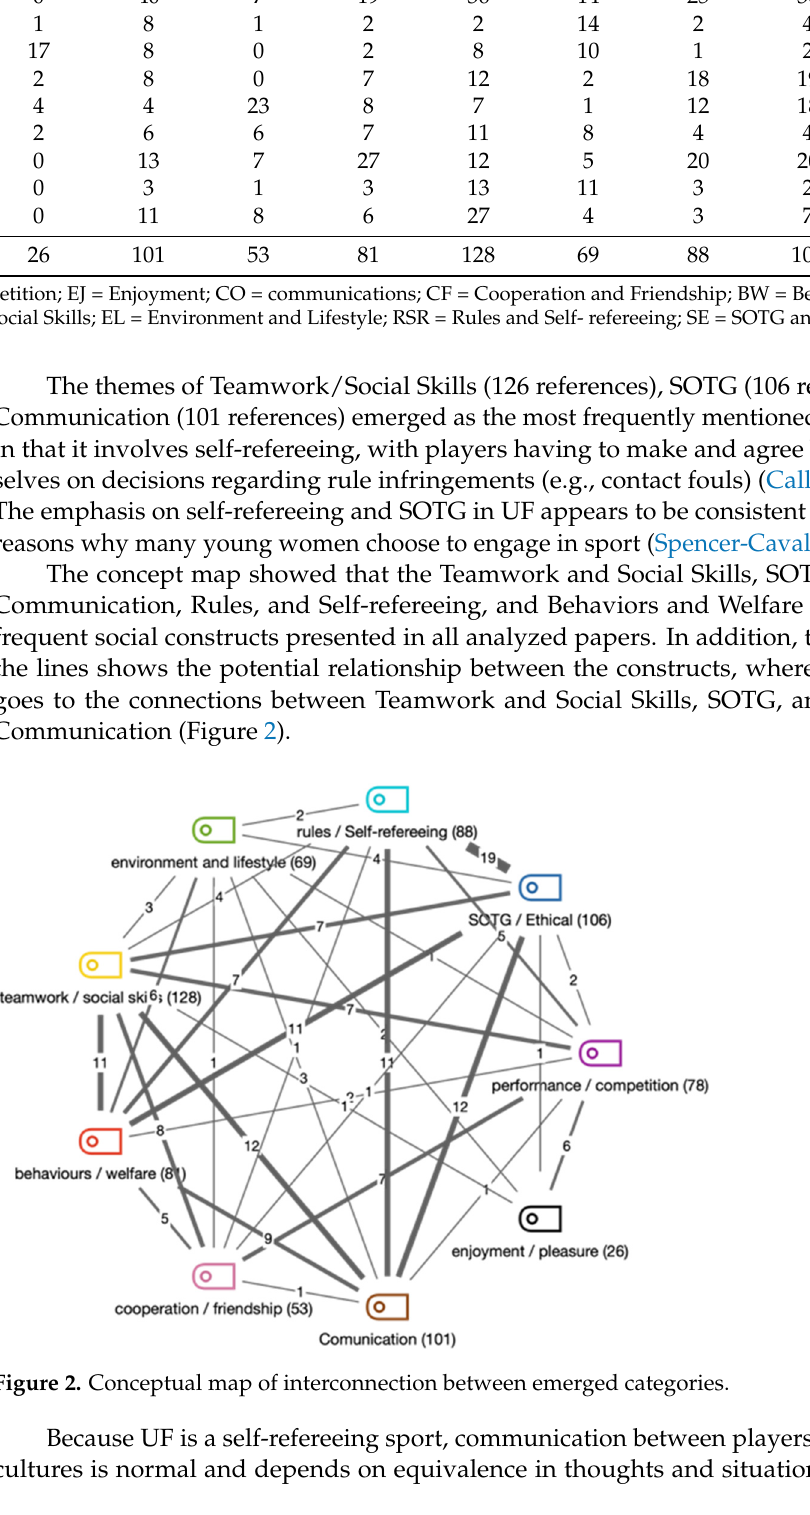
Table 3. Methodological interpretation of the included studies in the review (n = 9). Refs.